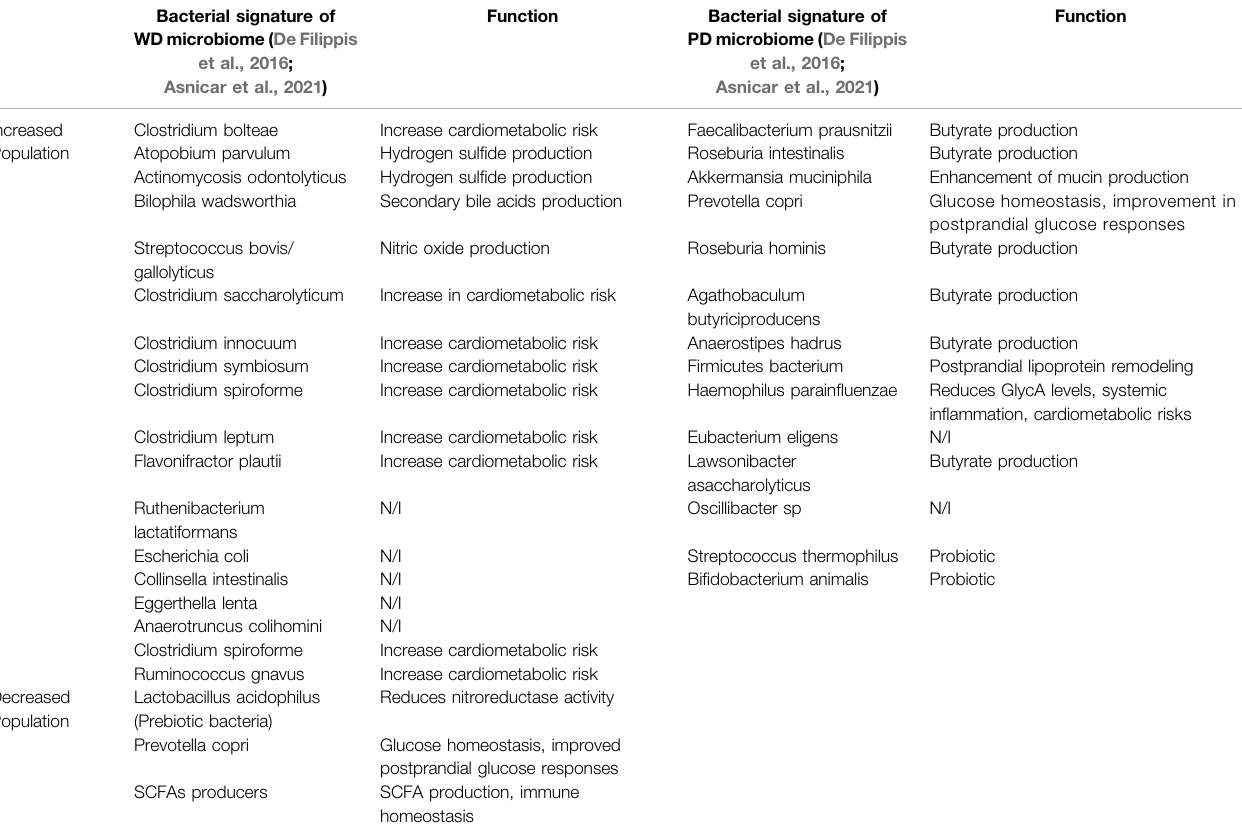
TABLE 2 | Microbial signatures of the gut microbiome, in respect to Western dietary (WD) pattern and plant-based (PD) dietary pattern (N/I non-identi fi ed). Bacterial signature of